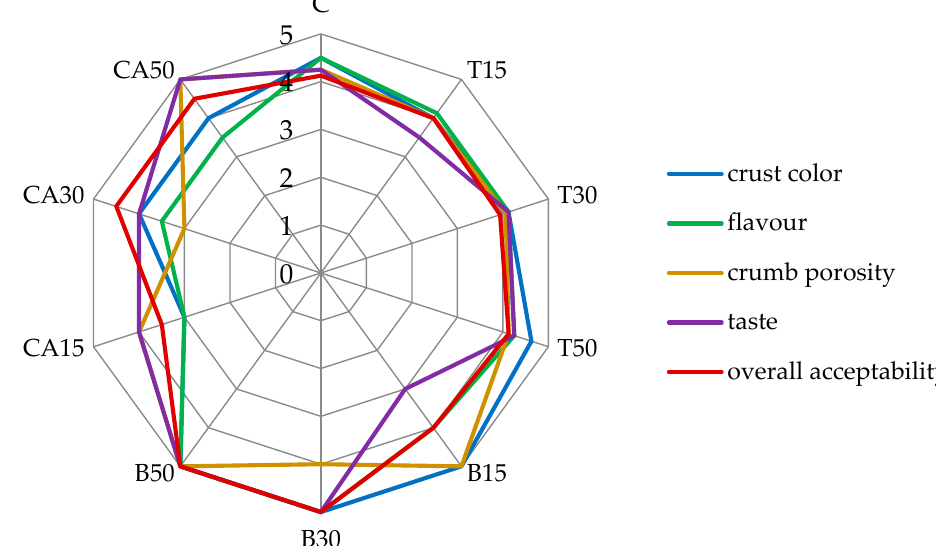
Figure 3. The scores of the sensory analysis of the obtained bread.